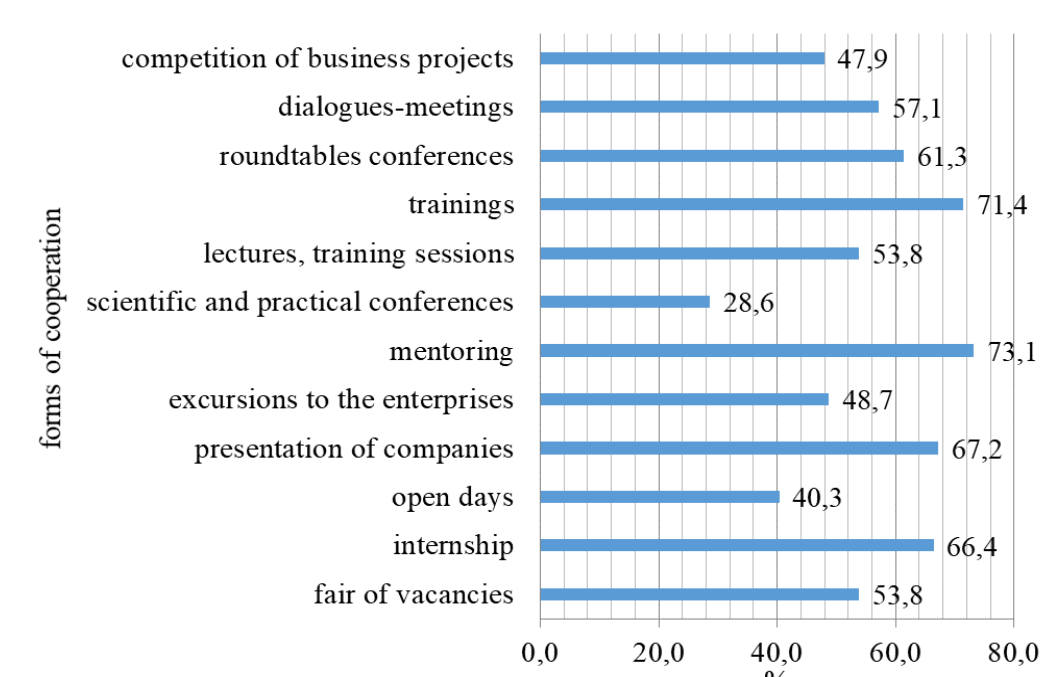
Fig. 2. Educational and career-forming forms of cooperation between the NUPh and the employers of the pharmaceuti- cal sector of the healthcare